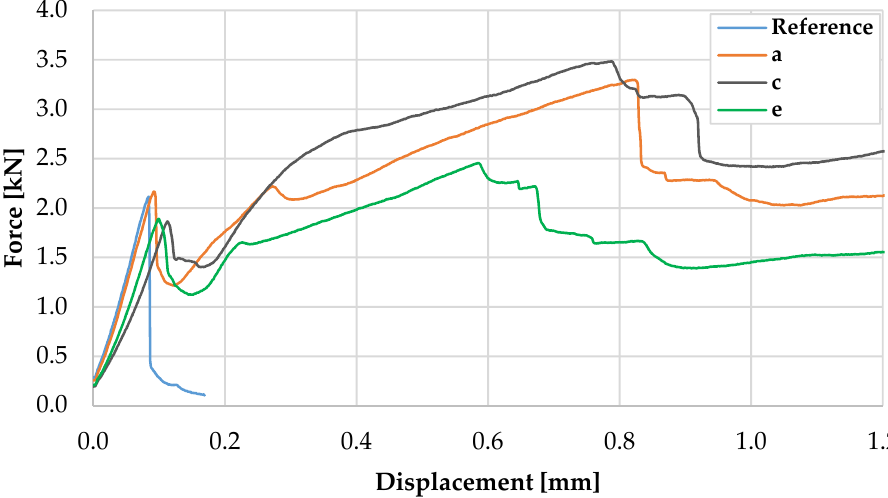
Figure 13. Representative force–displacement curves for specimen with a cross-section of 40 mm × 40 mm. Table 3. Results of bend tests on specimens with a cross-section of 40 mm × 40 mm.